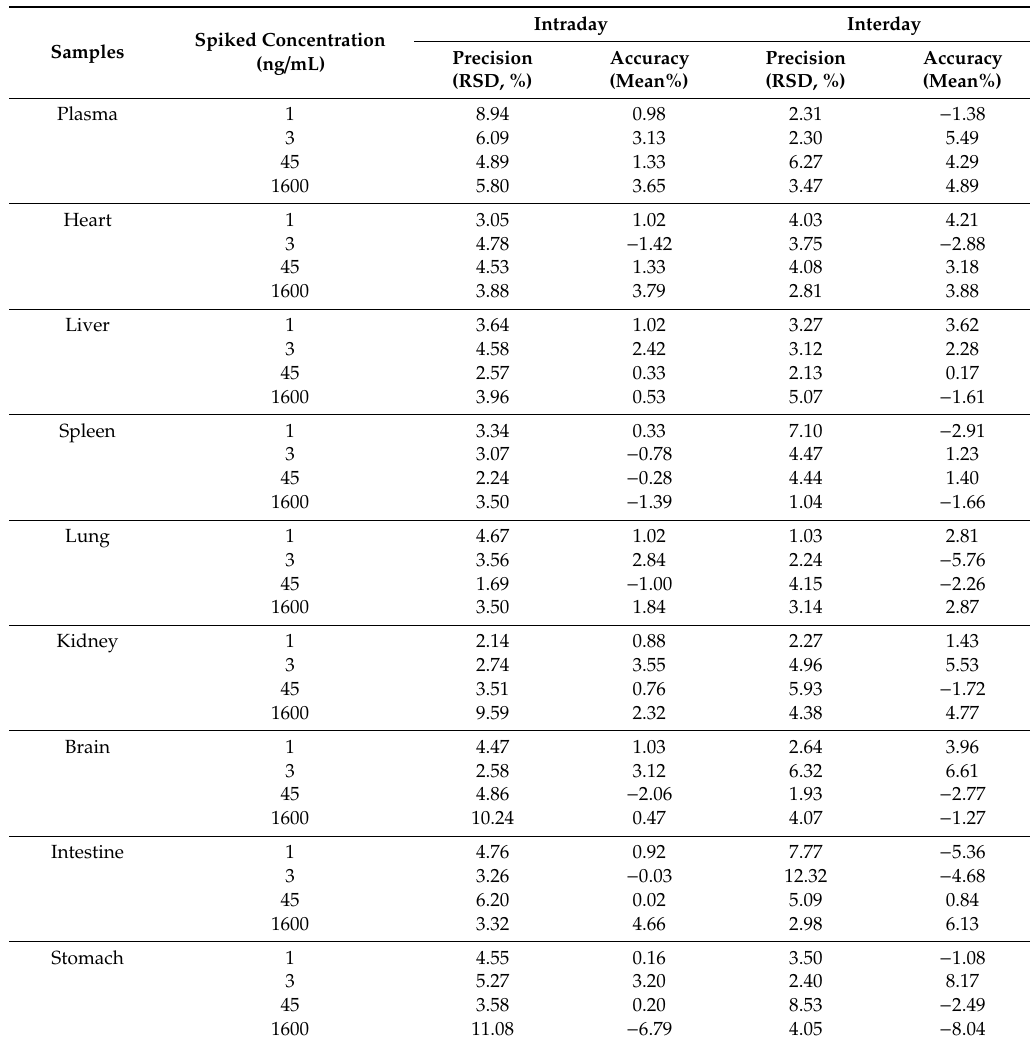
Table 3. Precision and accuracy of gardneramine in rat plasma and tissue homogenates ( n = 6).